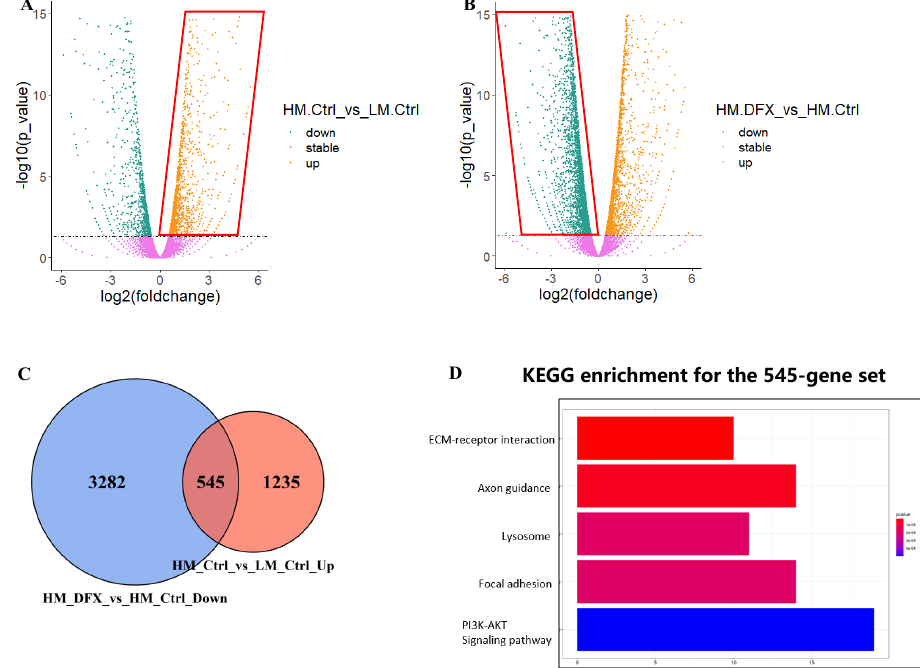
Figure 4. Bulk RNA–seq data analysis shows that DFX more notably inhibits 4T1–HM than 4T1–LM by specifically inhibiting Pi3k–Akt pathway. ( A , B ) 4T1–HM and 4T1–LM cells were treated for 48 h with DFX (50 µ mol/L) or with equivalent DMSO alone, nominated as HM_Ctrl, LM_Ctrl, HM_DFX, and LM_DFX. Four groups of samples were performed with bulk RNA–seq assay. The different expression gene sets were presented with volcano plots including the different gene expression of HM_Ctrl vs. LM_Ctrl and HM–DFX vs. HM_Ctrl. ( C ) The upregulated gene set in ( A ), and the downregulated gene set in ( B ) were merged with as presented on Venn graph. ( D ) KEGG enrichment was performed with the merged gene set, which showed that Pi3k–Akt pathway might be a potential mechanism underlined DFX more predominant inhibitory effects on 4T1–HM cell. Different expression genes were thought as significant change with a parameter of FDR < 0.05, and logFC > 0 as upregulated otherwise down regulated